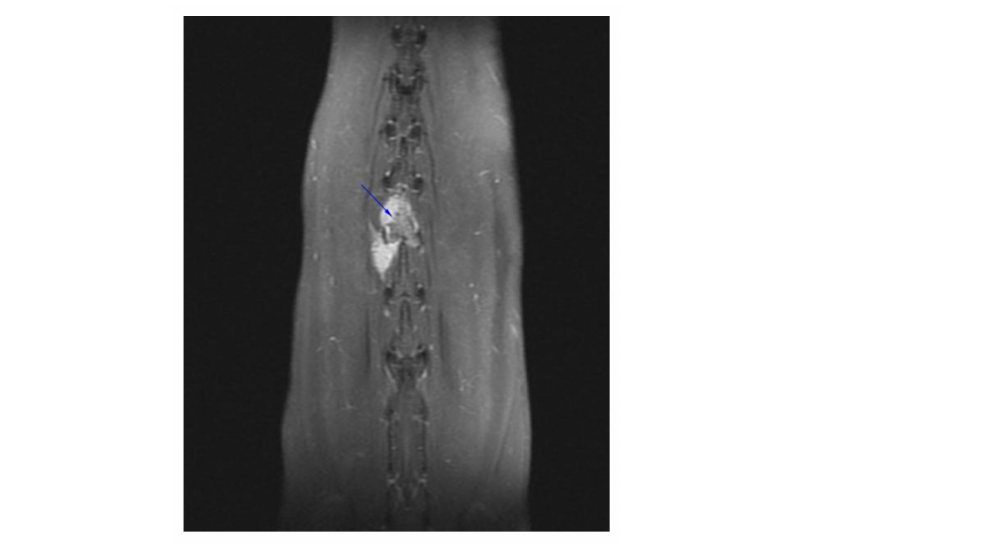
Figure 3. Post-contrast dorsal T1W image showing the contrast enhancement of the lamina of L2 in the middle of the mass (blue arrow).